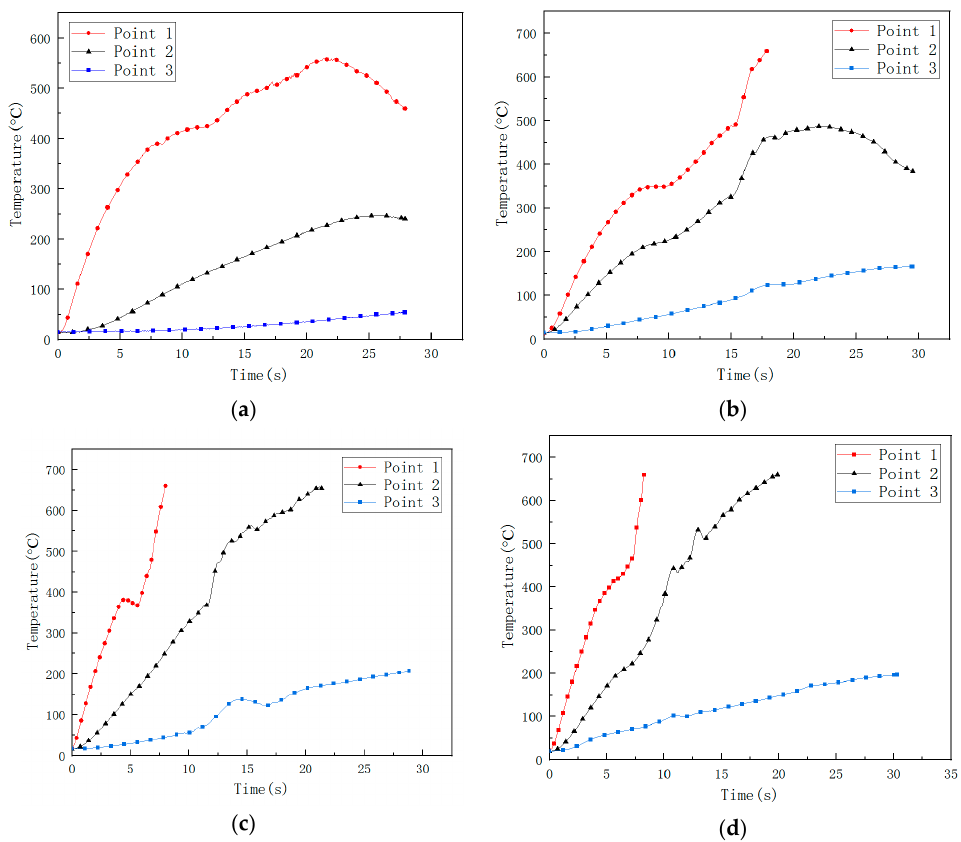
Figure 16. The temperature curve of different points at CFRP laminated rear surface. ( a ) 250 W; ( b ) 500 W; ( c ) 750 W; ( d ) 1000 W.